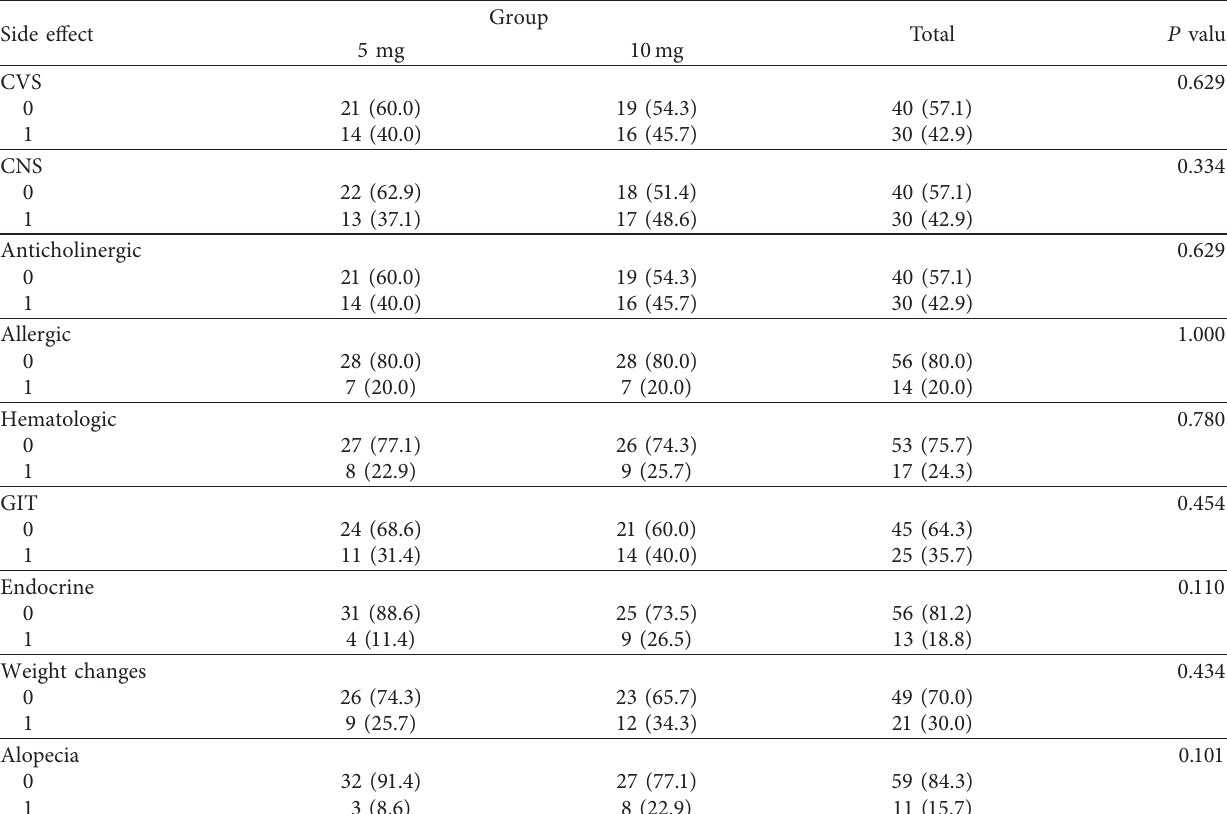
Table 4: Incidence of side effects in patients with chronic neck pain treated with 5 and 10 mg amitriptyline.